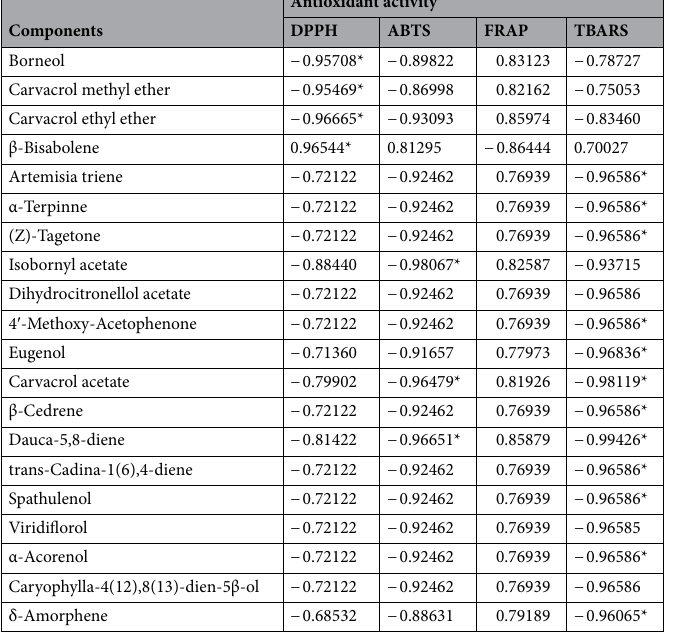
Table 3. The correlations between thyme oil components and antioxidant activities. ** and *: significant at the 0.01 and 0.05 probability levels,